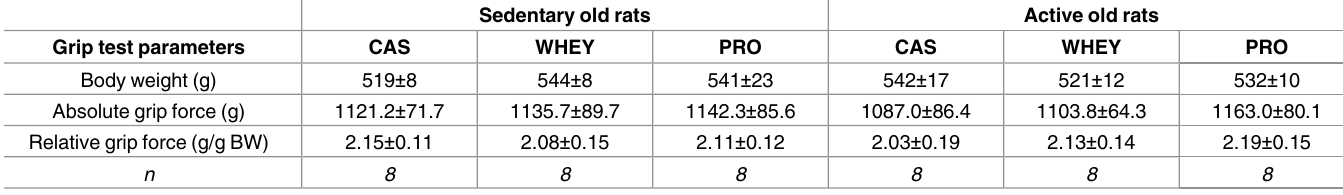
Table 5. Sedentary or active old rats had similar forelimb grip strengths regardless of the protein supplementation.